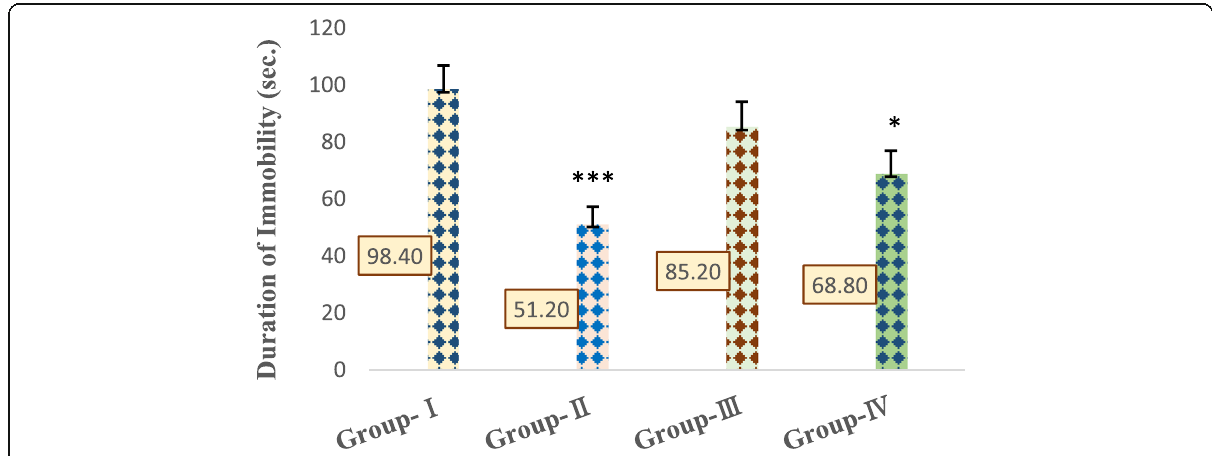
Fig. 7 Effect of Psidium guajava Linn leaves extract on the duration of immobility in tail suspension test. Group I = control group, group II = positive control group, group III = Psidium guajava Linn low strength group, group IV = Psidium guajava Linn high strength group. * p < 0.05, *** p < 0.001 vs group